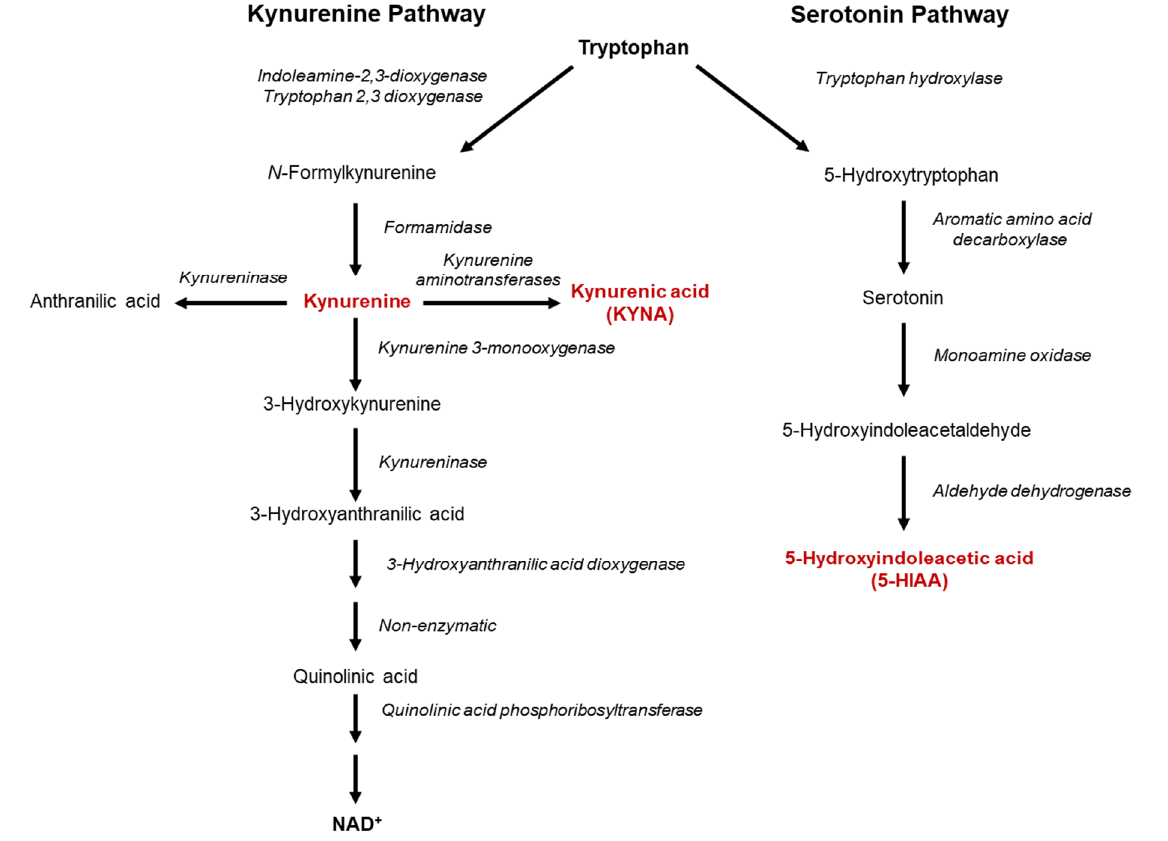
Figure 1. Tryptophan degradation through the kynurenine and serotonin pathways.